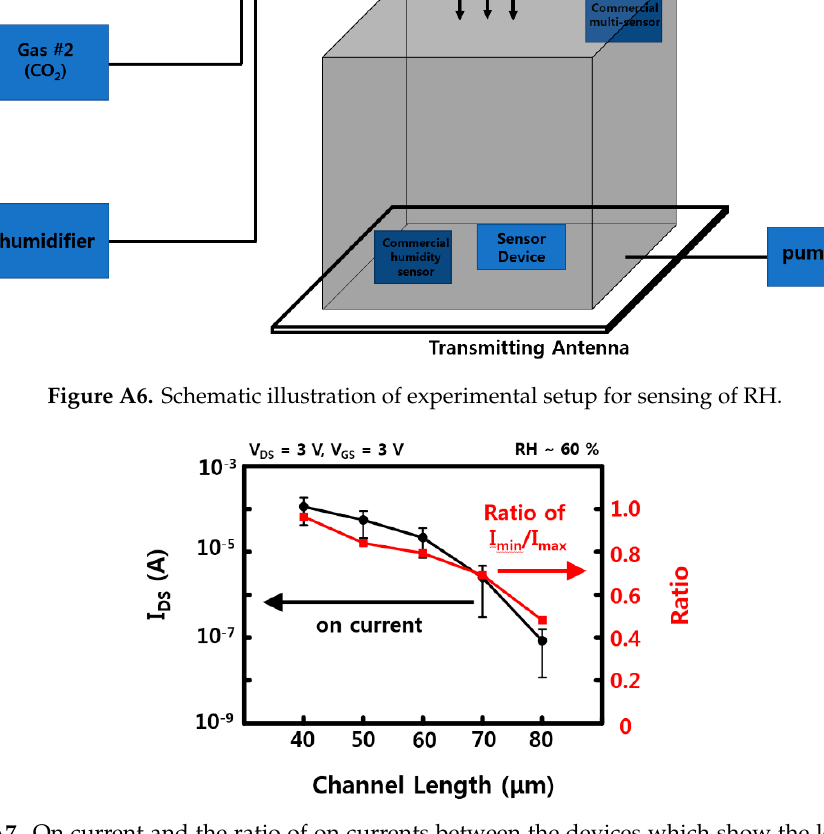
current and the device which shows the highest on current as a function of channel length, using 10